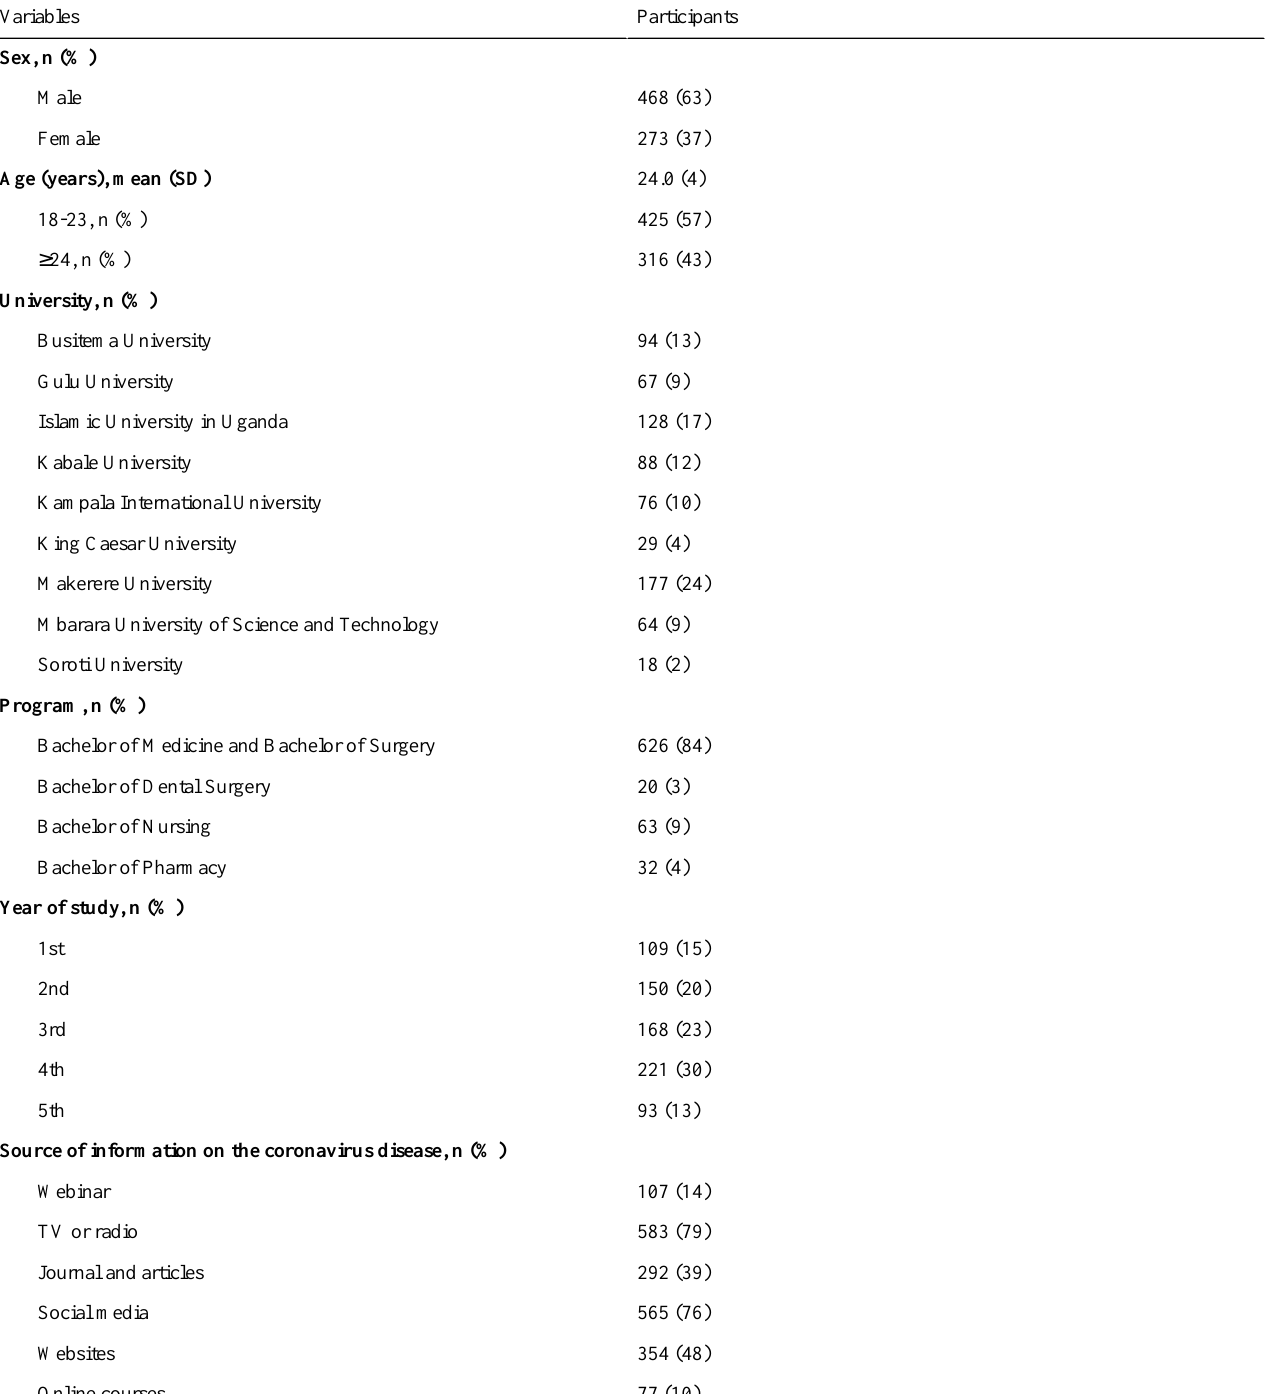
Table 1. Sociodemographic characteristics of the participants